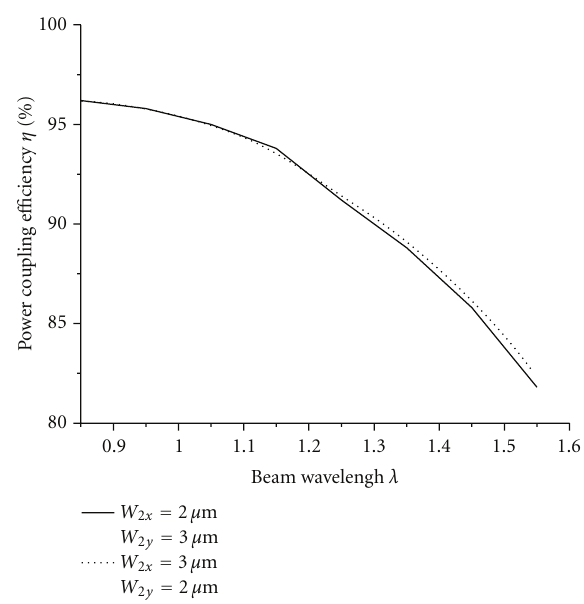
Figure 9: Power coupling e ffi ciency η is shown as a function of beam wavelength λ for two di ff erent beam spot sizes at the beam waist. The fibre parameters are n 1 = 1 . 45, Δ = 1% and NA = 0 .